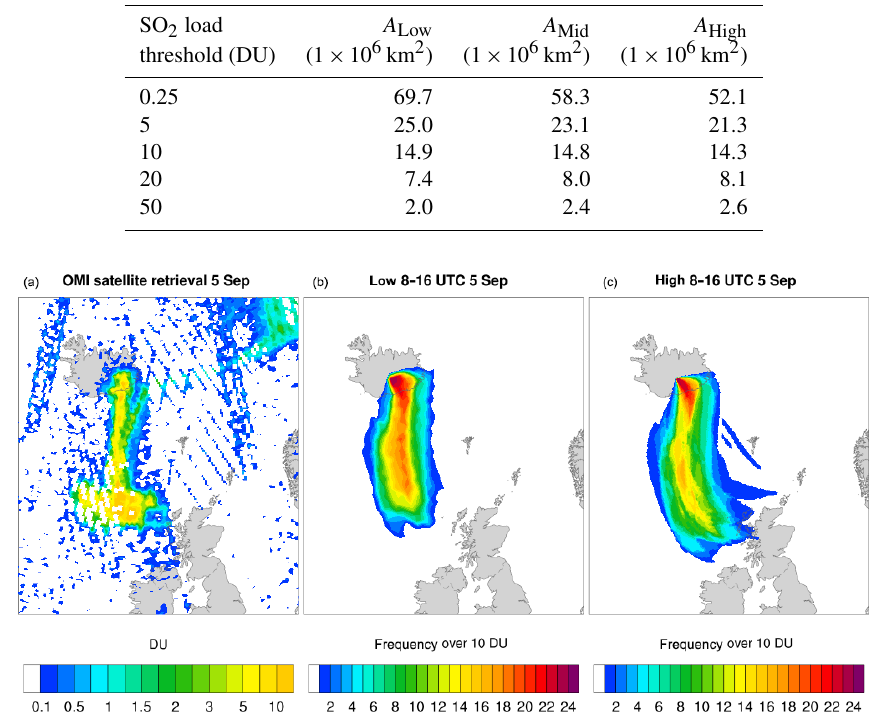
Figure 5. OMI retrieval of SO 2 (left) for the satellite overpasses between 08:00 and 16:00UTC on 5 September. Frequency of ensemble members over 10DU for the low (middle) and high (right) resolution runs. Frequencies are computed every hour and averaged over the same time period, using the forecast runs started on 4 September